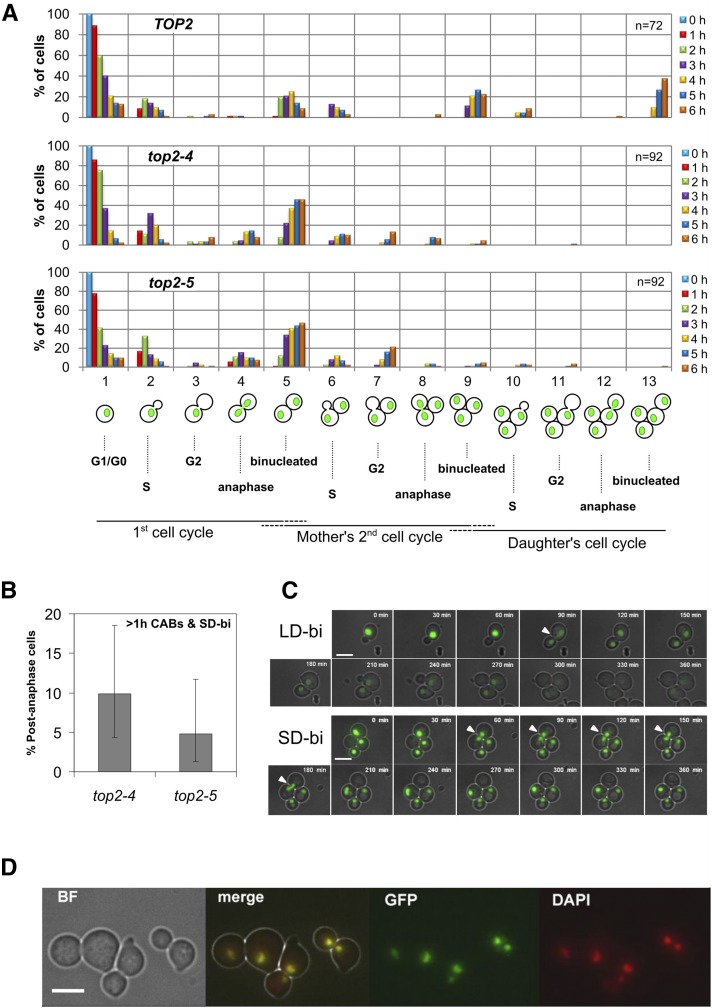
Single-cell live microscopy of top2-4 and top2-5 alleles for the first two cell cycles at the restrictive temperature. (A) HTA2-GFP cells carrying different alleles of the TOP2 gene (TOP2, top2-4 and top2-5) were grown at 25°, concentrated to OD600 = 3, spread onto YPD agarose patches, and filmed under the microscope at 37° for 6 hr, taking images every 1 hr. Several films were independently recorded and the subpopulation of cells which were at G1 (unbudded) at the time of the temperature shift were followed (cell number is indicated on the upper right corner of each bar chart). Each hour, cells were either kept in their preceding category (starting at “1,” first cell cycle G1) or moved into one of the 13 categories shown on the X-axis. The bar charts represent the percentage of cells in each of these categories at any given time point. Horizontal dashed line ends under the categories indicate uncertainty about which cell cycle stage cells are in (e.g., category “5” grouped those cells which are in the first cell cycle’s telophase together with those mother and daughter cells in the second cycle’s G1). (B) Analysis of cells where anaphase lasted longer than 1 hr in the cells studied in (A); i.e., cells that remained in category “4” for at least two successive frames. Only cells that reached or passed the first anaphase were considered for the analysis. Error bars represent CI95 of the cell proportion. (C) The same top2-ts HTA2-GFP strains used for (A) were filmed again at 37° but taking images every 30 min. Representative cells where a CAB was seen are shown. The upper “LD-binucleated” example is from a top2-5 cell and the lower “SD-binucleated” example is taken from a top2-4 cell. White-filled triangles pointing to H2A-GFP CABs are included in the corresponding frames. (D) HTA2-GFP top2-4 after 4 hr at 37° in liquid cultures showing a perfect colocalization of H2A-GFP and DAPI staining in cells with the SD-binucleated morphology. The bar corresponds to 5 μm. BF, bright field.